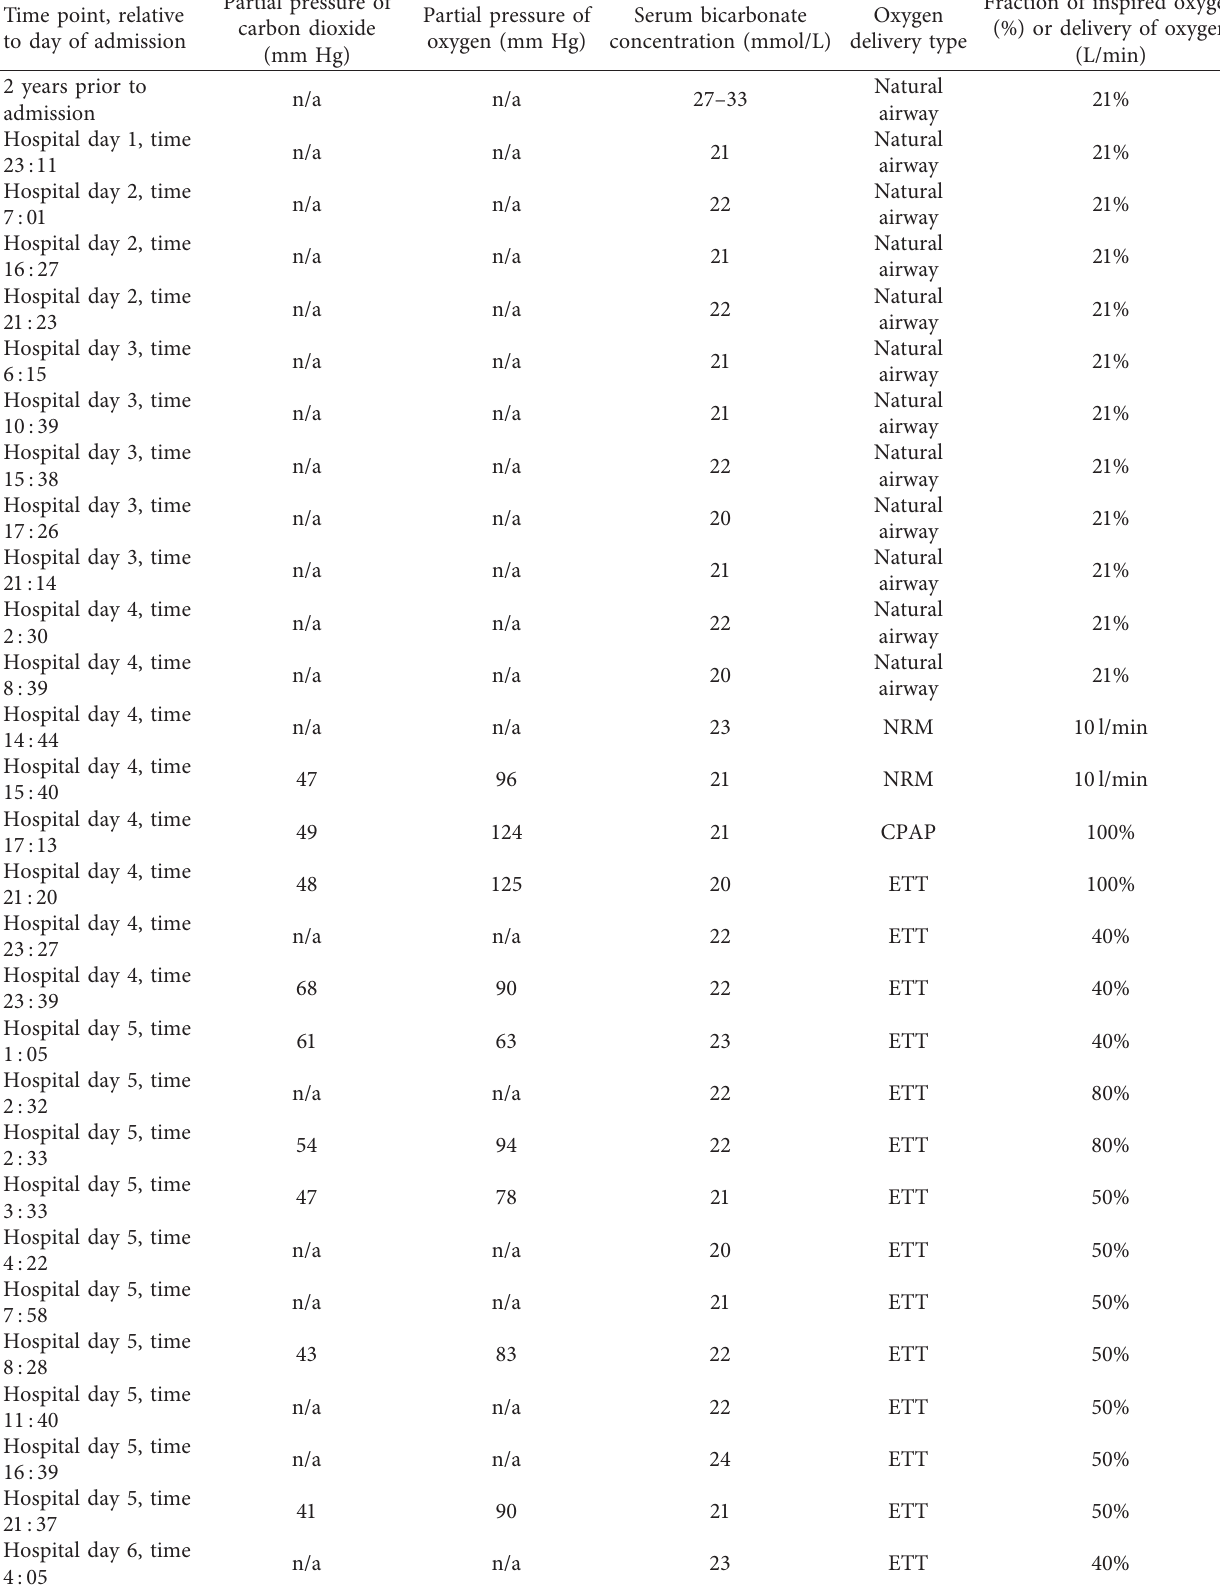
Table 1: Arterial blood gas values from preconception to